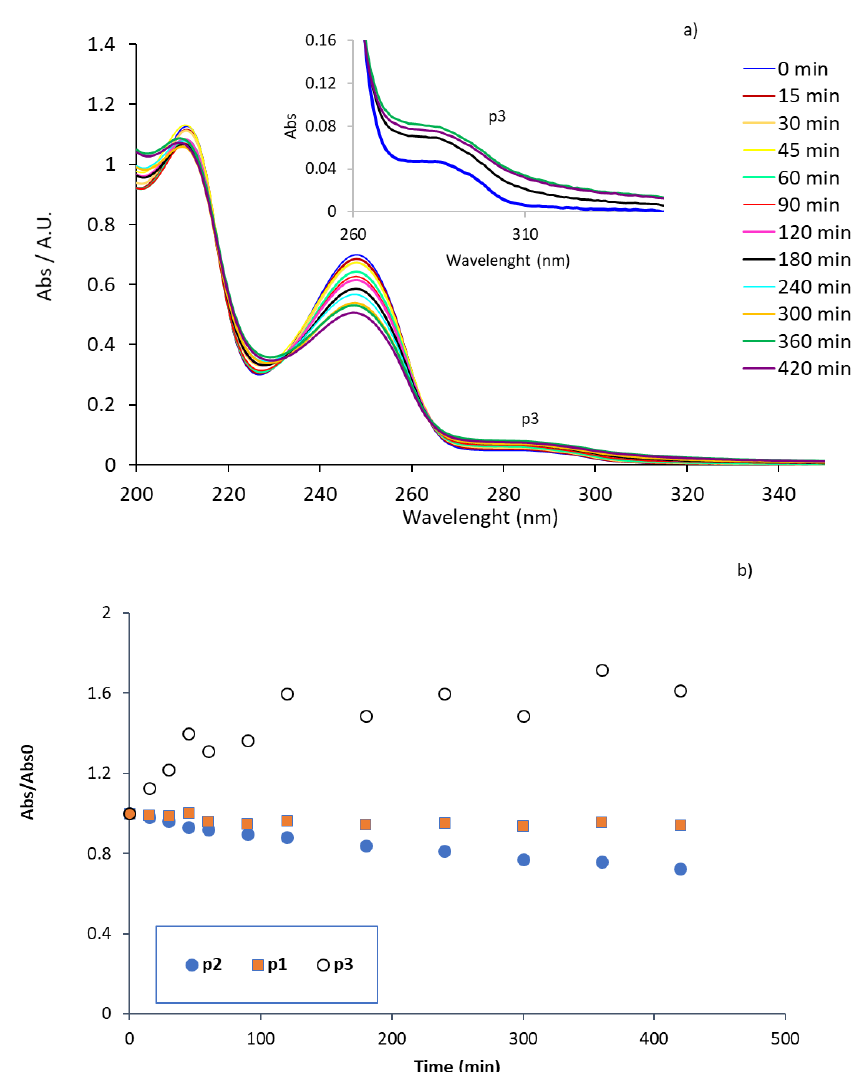
Figure 7. Trend with time of the spectra of absorbance (panel a ) and the height of the peaks (panel b ) p1, p2 and p3, normalized with respect to their initial values obtained for I = 0.5 mA, Q = 60 mL min − 1 = 10 ppm. and C 0 = 10 ppm. and C 0